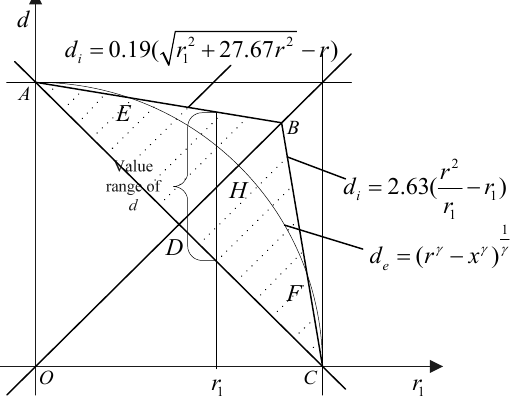
Figure 16. The feasible region of energy-efficiency and interference-optimality in homogeneous networks.